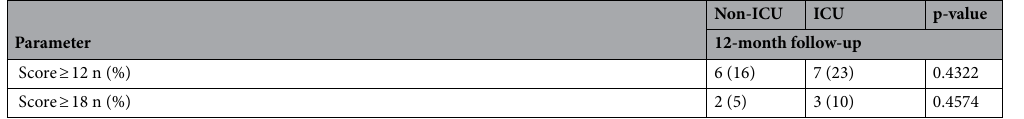
Table 3. Questionnaire results testing for perceived stress, fatigue, and posttraumatic stress symptoms at the 12-month follow-up. PSS-10 (Perceived Stress Scale-10) respondents are asked to rate each of the items on a scale of 0 to 4 based on how much a symptom has bothered them during the last month (0: never, 1: almost never, 2: sometimes 3: fairly often 4: very often). Scores for questions 4, 5, 7, and 8 are inverted. On these 4 questions, the scores are changed like this: 0 = 4, 1 = 3, 2 = 2, 3 = 1, 4 = 0. Scores are subsequently added up to get a total. Scores ranging from 0 to 13 would be low stress, scores ranging from 14 to 26 would be considered moderate stress and scores ranging from 27 to 40 would be considered high-perceived stress, respectively. FACIT-F (Functional Assessment of Chronic Illness Therapy – Fatigue) respondents are asked to rate each of the items on a scale of 0 to 4 based on the past 7 days. Scores on items 7 and 8 are reversed like this: 0 = 4, 1 = 3, 2 = 2, 3 = 1, 4 = 0. Scores are subsequently added up to a total. Scores < 30 indicate severe fatigue. PTSS-10 (Posttraumatic Symptom Scale-10) respondents are asked to rate each of the items on a scale of 0 to 3 (0: never, 1: rarely, 2: sometimes 3: often). PTSS-10 scores are subsequently added up to get a total.scores interpreted according to the following levels: 0 to 11 (mild to moderate) and 12 to 30 (moderate to severe). A score ≥ 18 represented a “case” and a score of ≥ 12 indicates the need for psychological help. Results are median plus interquartile range or percentage of patients as indicated. Significant values are in